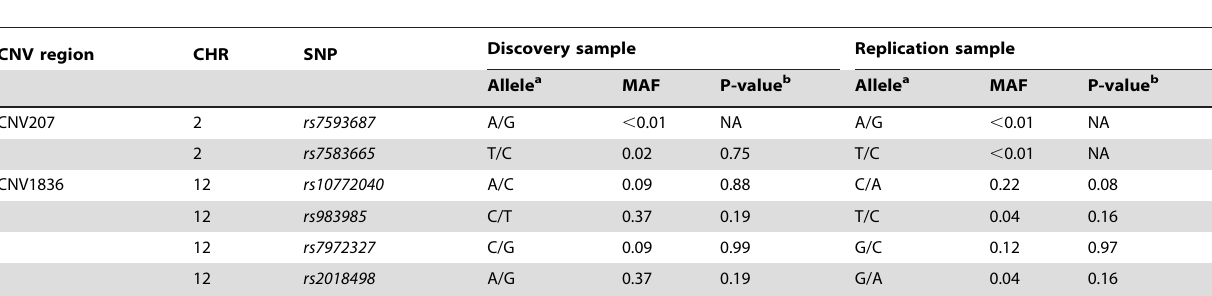
Table 3. Association between SNPs located in CNV207 and CNV1836 region and alcohol drinking.